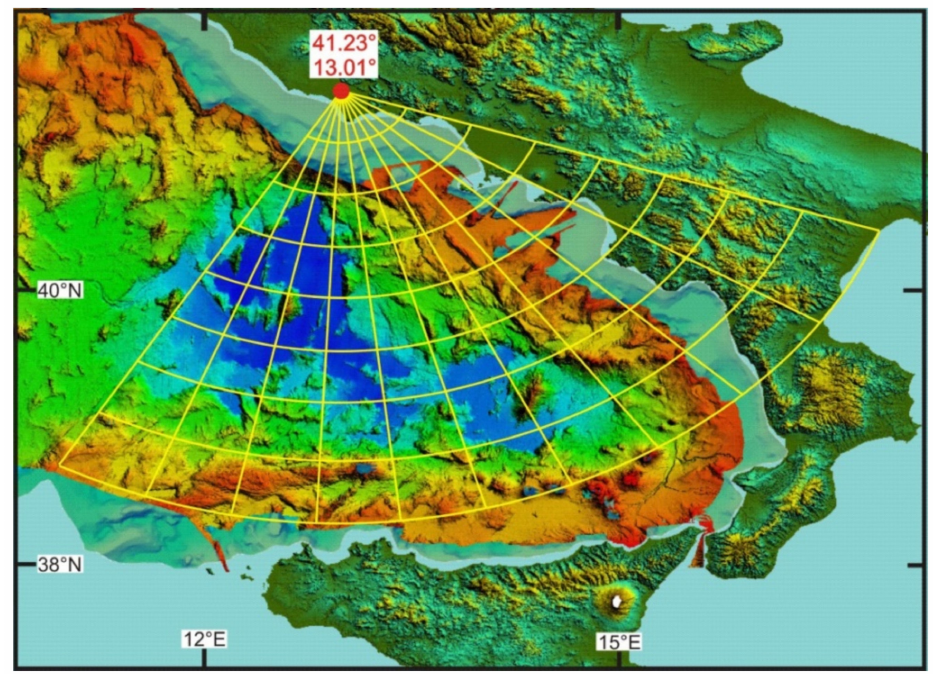
Figure 15. Morpho-structural lineaments of the southern sector and Euler pole of relative motion with respect to Corsica ( red dot ). The Euler pole grid shows the goodness of fit between kinematic model and geological